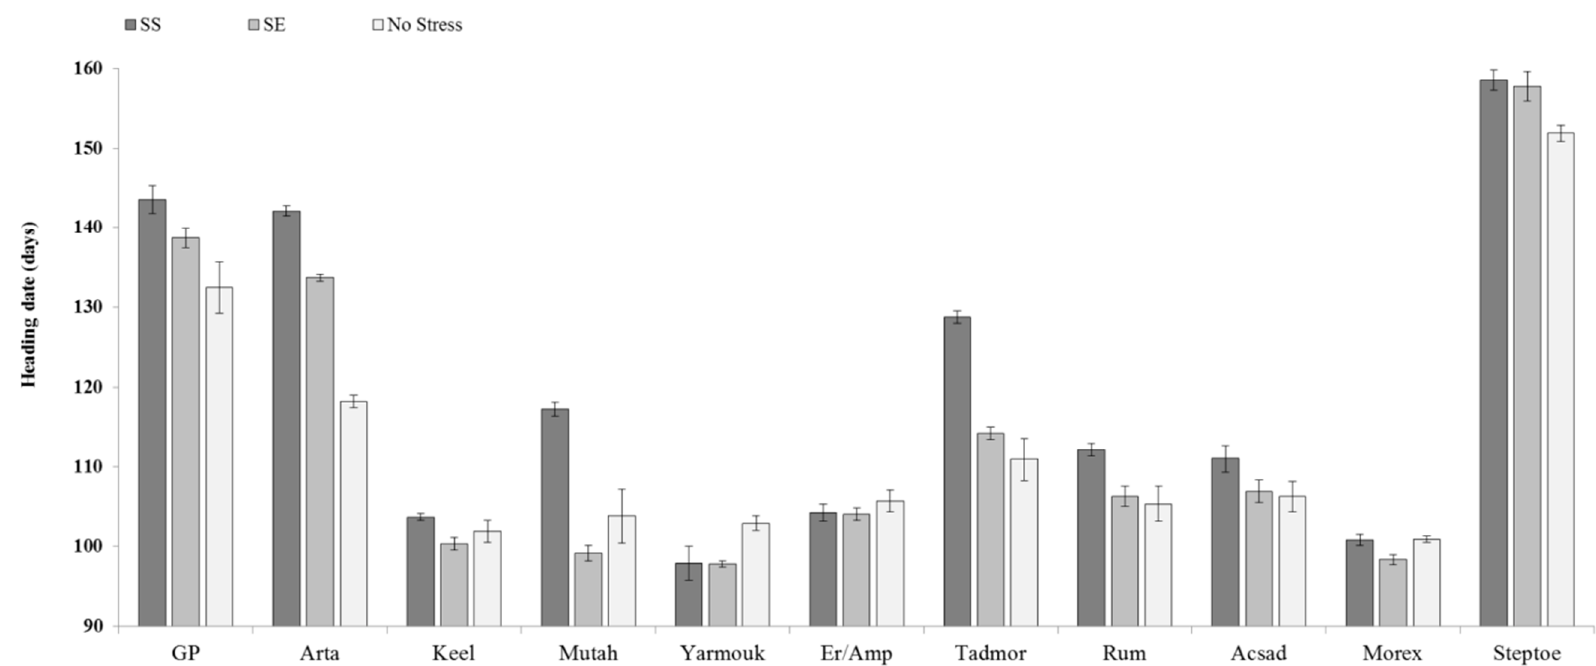
Figure 1. Heading dates of 11 barley genotypes grown under glasshouse conditions and subjected either to well-watered conditions (No stress) or to drought stress at two different growth stages: seedling stage (SS) and stem elongation stage (SE). Bars represent standard errors of means of six replicates.